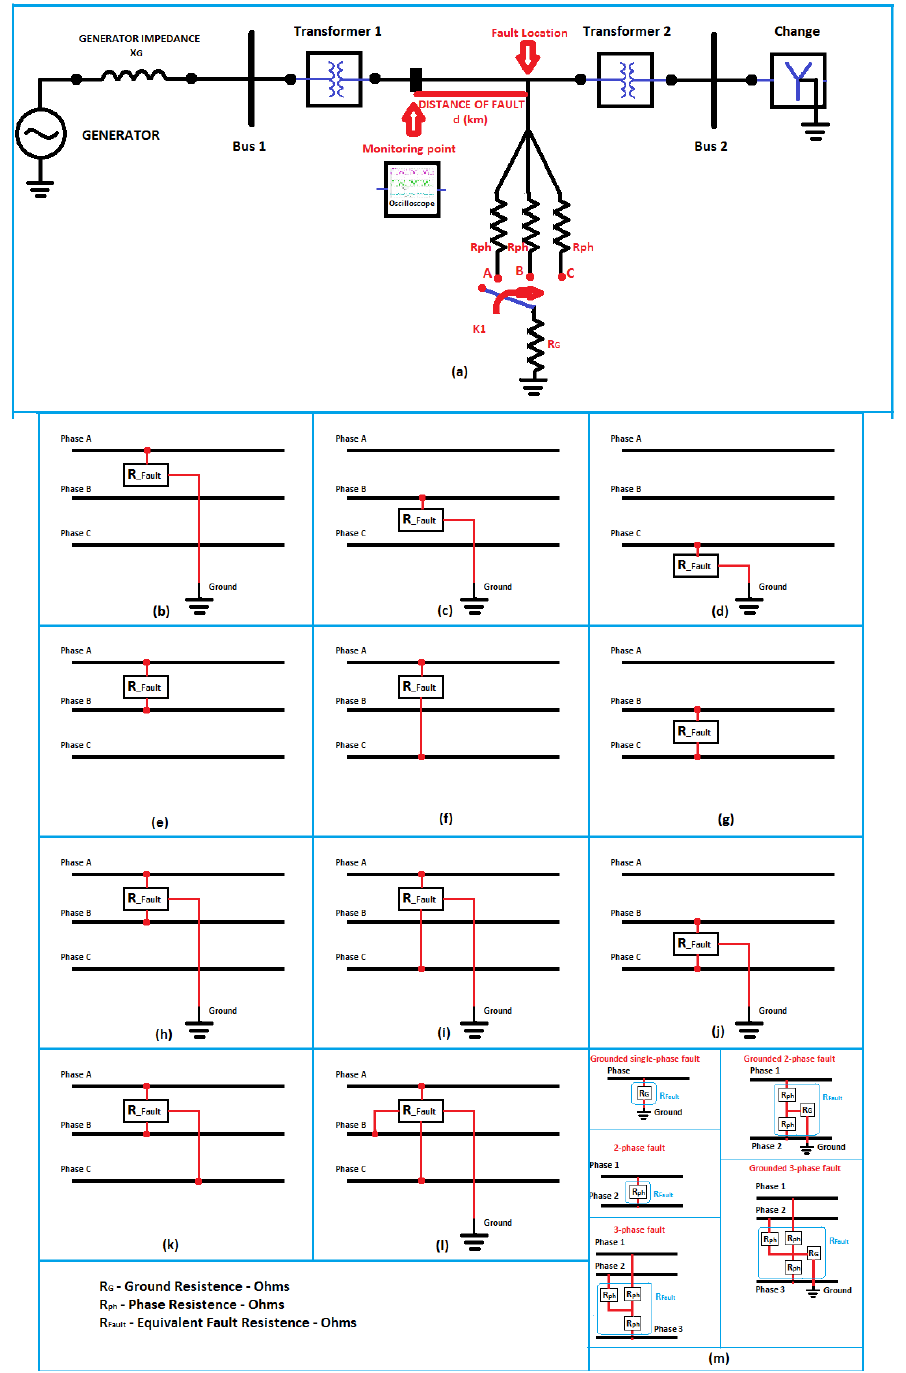
Figure 1. Simulated line topology in the ATP R (cid:13) software. Fault situations for a three-phase system. All fault settings for a three-phase system are also shown. Situations of single-phase faults: Figure 1b–d. Situations of biphasic faults: Figure 1e–g. Situations of grounded biphasic faults: Figure 1h–j. Situation of three-phase fault: Figure 1k. Situations of grounded three-phase fault: Figure 1l. Settings of phase resistors R p h and ground resistance R G : Figure 1m. Table 2 shows all situations of simulated faults with variations of the fault type (elements involved are phases A , B , C and ground G ), signal sampling, line fault position, fault resistance, and incident angle of the